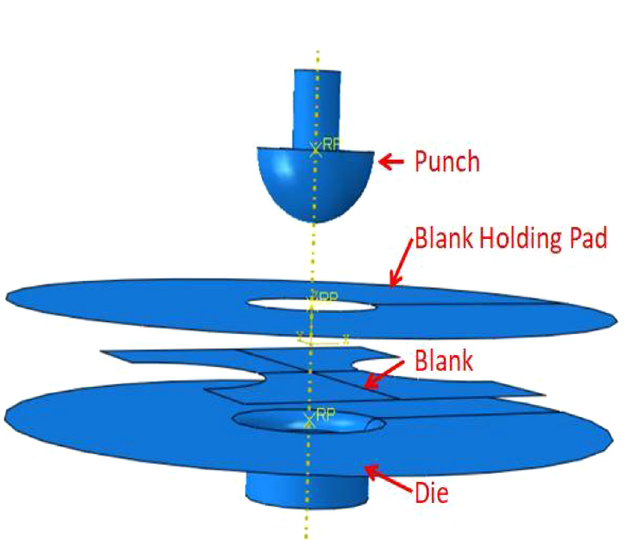
Fig. 3. Modeling of the process tool with Abaqus for